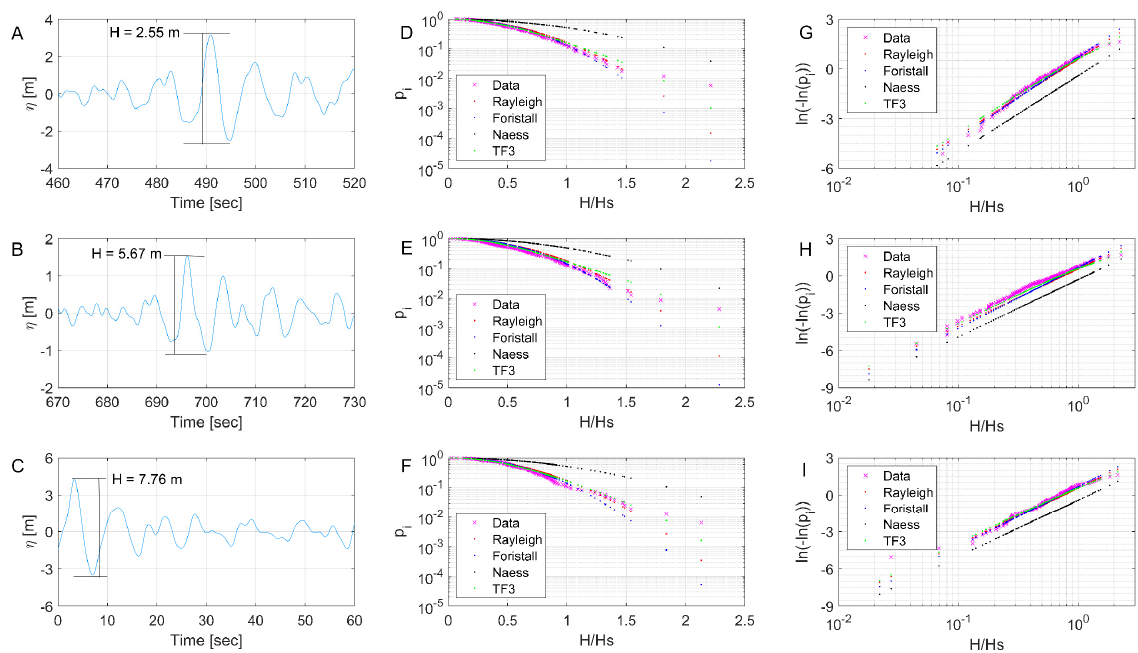
Figure 6. ( A – C ) presents three different time series containing rogue waves with their corresponding EDFs ( D – F ) and linear EDF presentation ( G – I ).